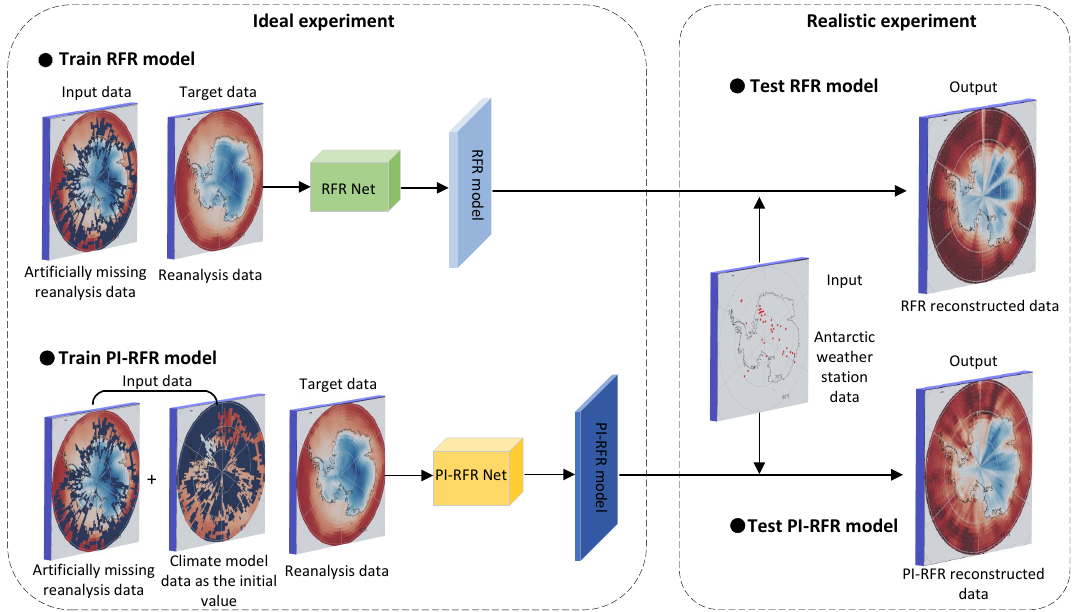
Figure 5. Overall framework with the RFR and PI-RFR methods for reconstructing the climatological spatial missing information. The left part is the ideal experiments, training the RFR and PI-RFR methods separately. The right part is the realistic experiments, with spatial missing reconstruction from the Antarctic site